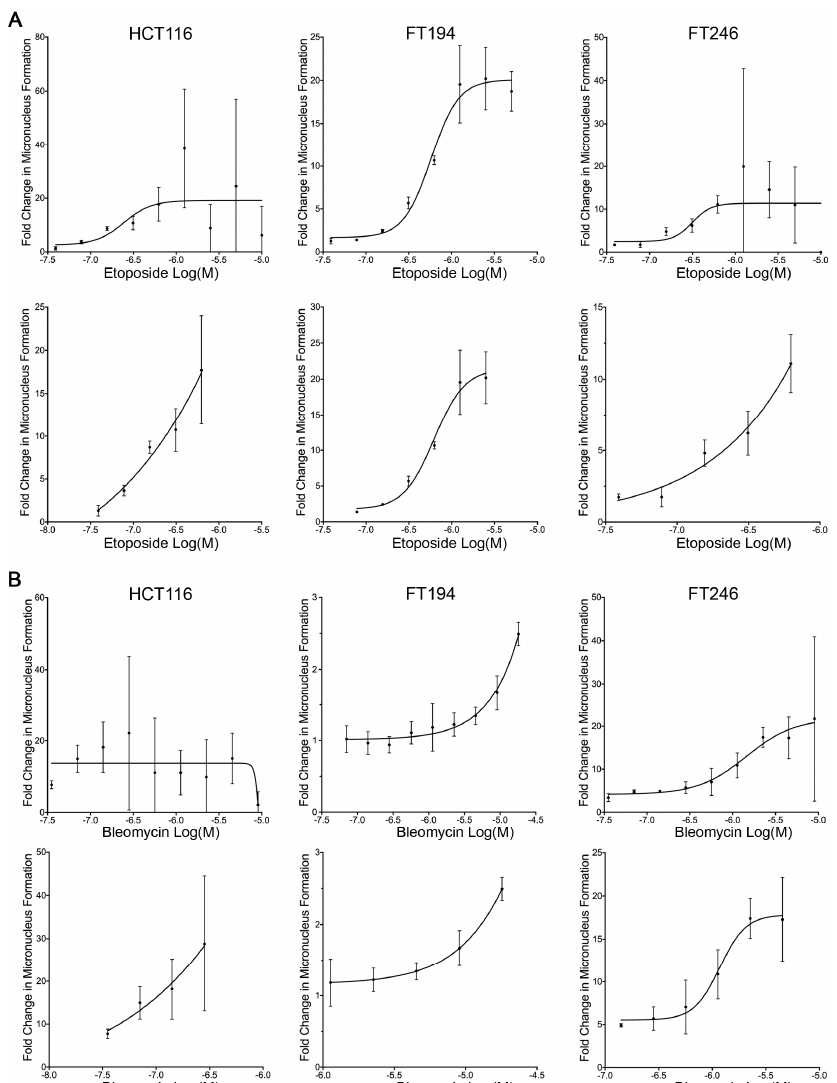
Figure 3. Increasing concentrations of etoposide and bleomycin correspond to increases in micronucleus formation. ( A ) Increasing concentrations of etoposide correspond to increases in micronucleus formation in HCT116 (left), FT194 (middle), and FT246 (right) cells. The (top) graphs present full dose ranges, while the (bottom) graphs present refined ranges. Presented are the mean ± SD for each concentration relative to the vehicle control. Each experimental condition was performed in triplicate. ( B ) Increasing concentrations of bleomycin induce increases in micronucleus formation in HCT116 (left), FT194 (middle), and FT246 (right) cells. (Top) graphs present full dose ranges, while (bottom) graphs present optimal ranges. Presented are the mean ± SD relative to the vehicle control for the experiments performed in triplicate.